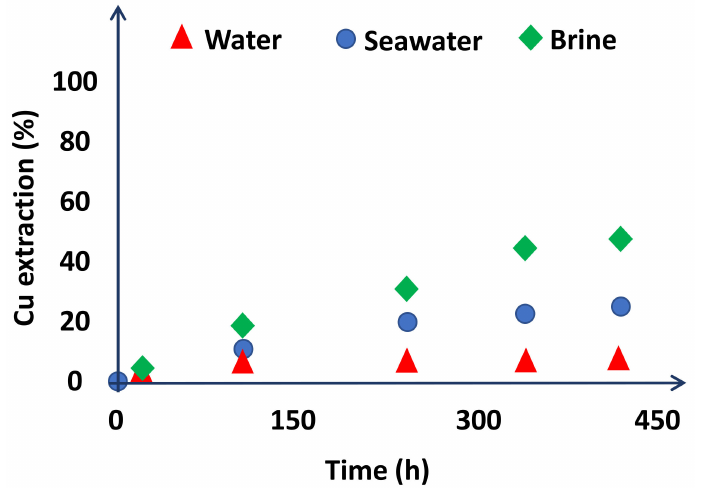
Figure 8. Copper extraction (%) versus time (h) when different dissolvents were used: distilled water (water), seawater, and brine. Experimental conditions: [NaNO 3 ] = 0.7 M, [H 2 SO 4 ] = 0.7